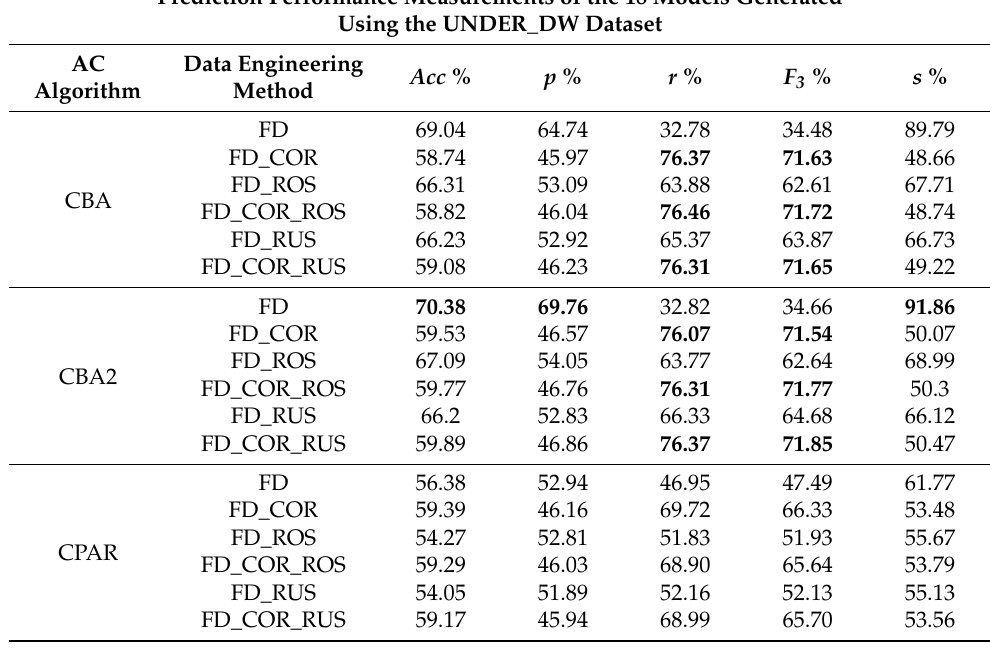
Table 10. Classification assessment of the 18 models generated using the UNDER_DW